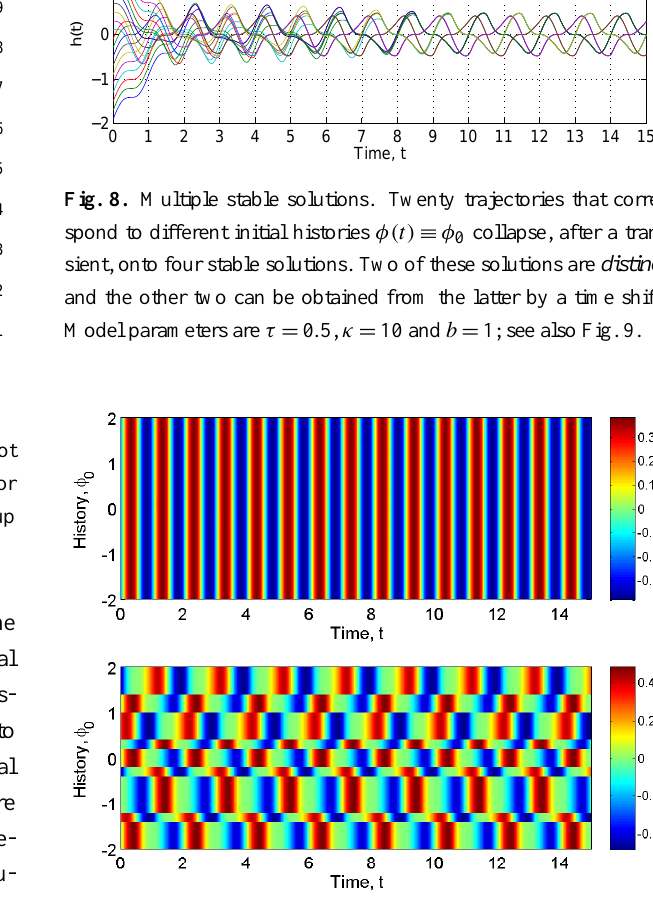
Fig. 9. Solution profiles for multiple constant histories φ(t) = φ 0 . The top panel corresponds to point A = (τ = 0 . 4 ,κ = 11 ,b = 2 ) in parameter space, where there exists a unique stable solution. The bottom panel corresponds to B = (τ = 0 . 5 ,κ = 10 ,b = 1 ) , the same point as in Fig. 8; here there exist two stable solutions and their attractor basins are bound by horizontal discontinuity lines in the solution profile. The solutions are shown after a sufficiently long transient, and the origin of the time is shifted to start from zero; colour bars indicate solution values, here as well as in Fig.